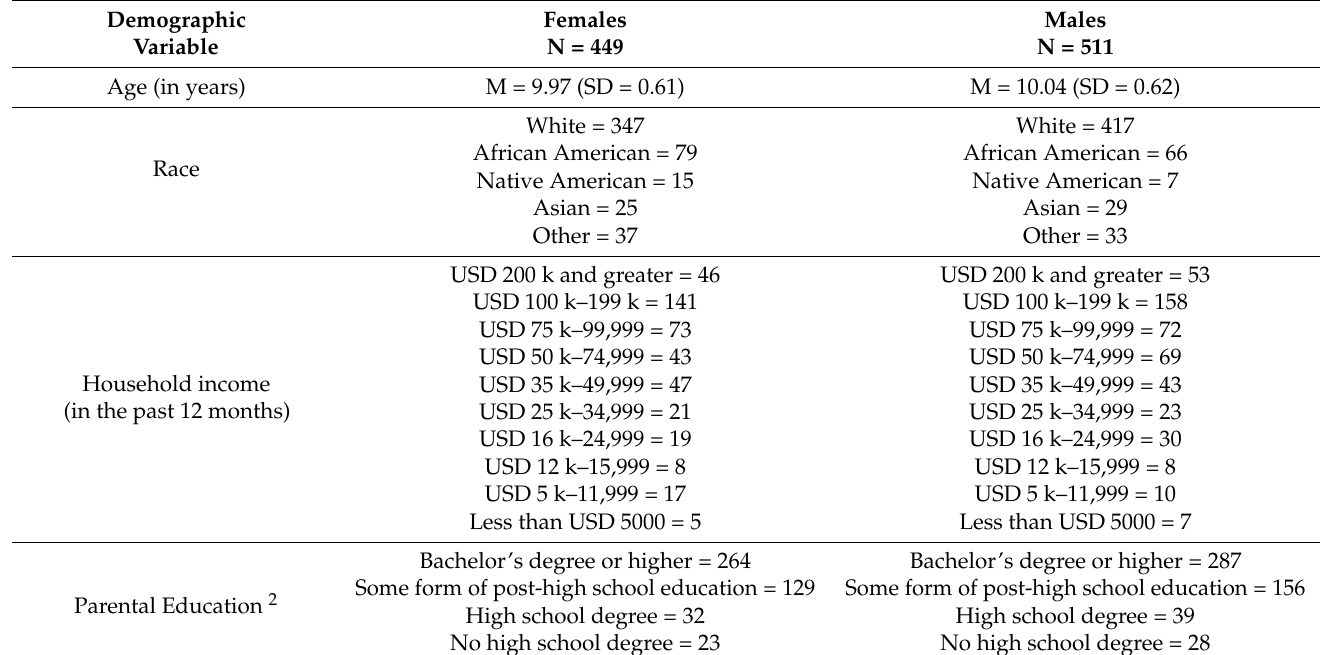
Table 1. Basic demographic information 1 .